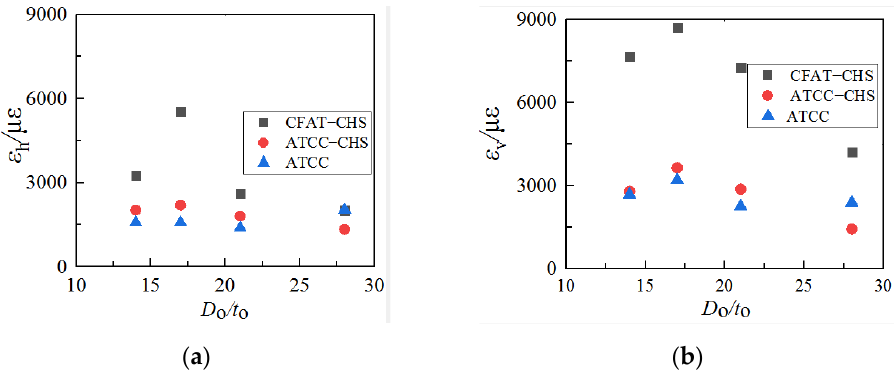
Figure 16. Relationship curve between ε h and ε v and the parameter-thickness ratio. ( a ) ε h – D o / t o relationships, ( b ) ε v – D o / t o relationships.